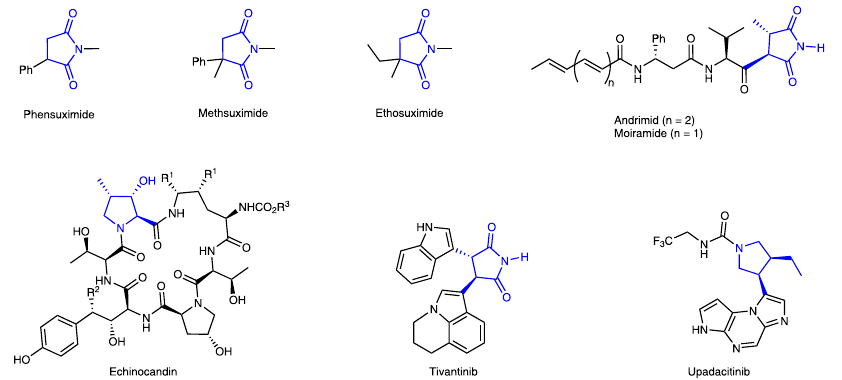
Fig. 1 | Biologically active compounds and drugs derived from succinimides. Phensuximide, methsuximide and ethosuximide are well-known antiepileptic drugs.Upadacitinibisadrugforthetreatmentofimmunedisorders,Echinocandins